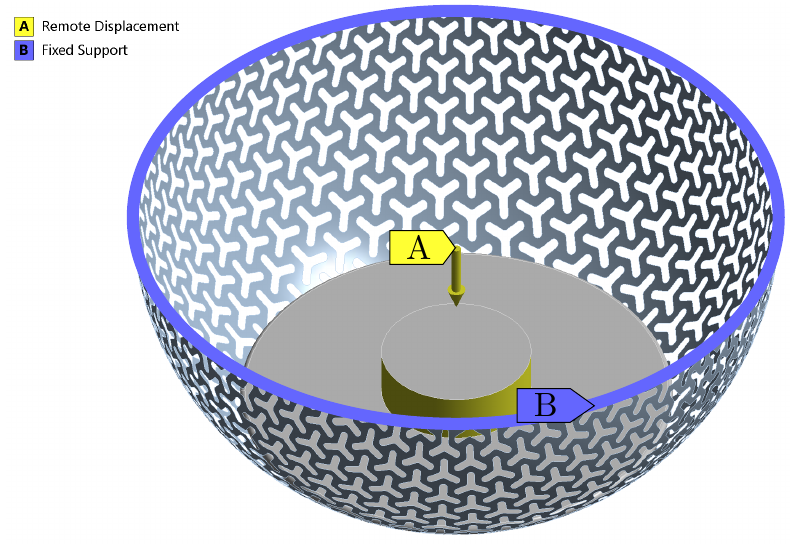
Figure 8. Boundary conditions for a full non-linear model analyses of load-bearing capacity.